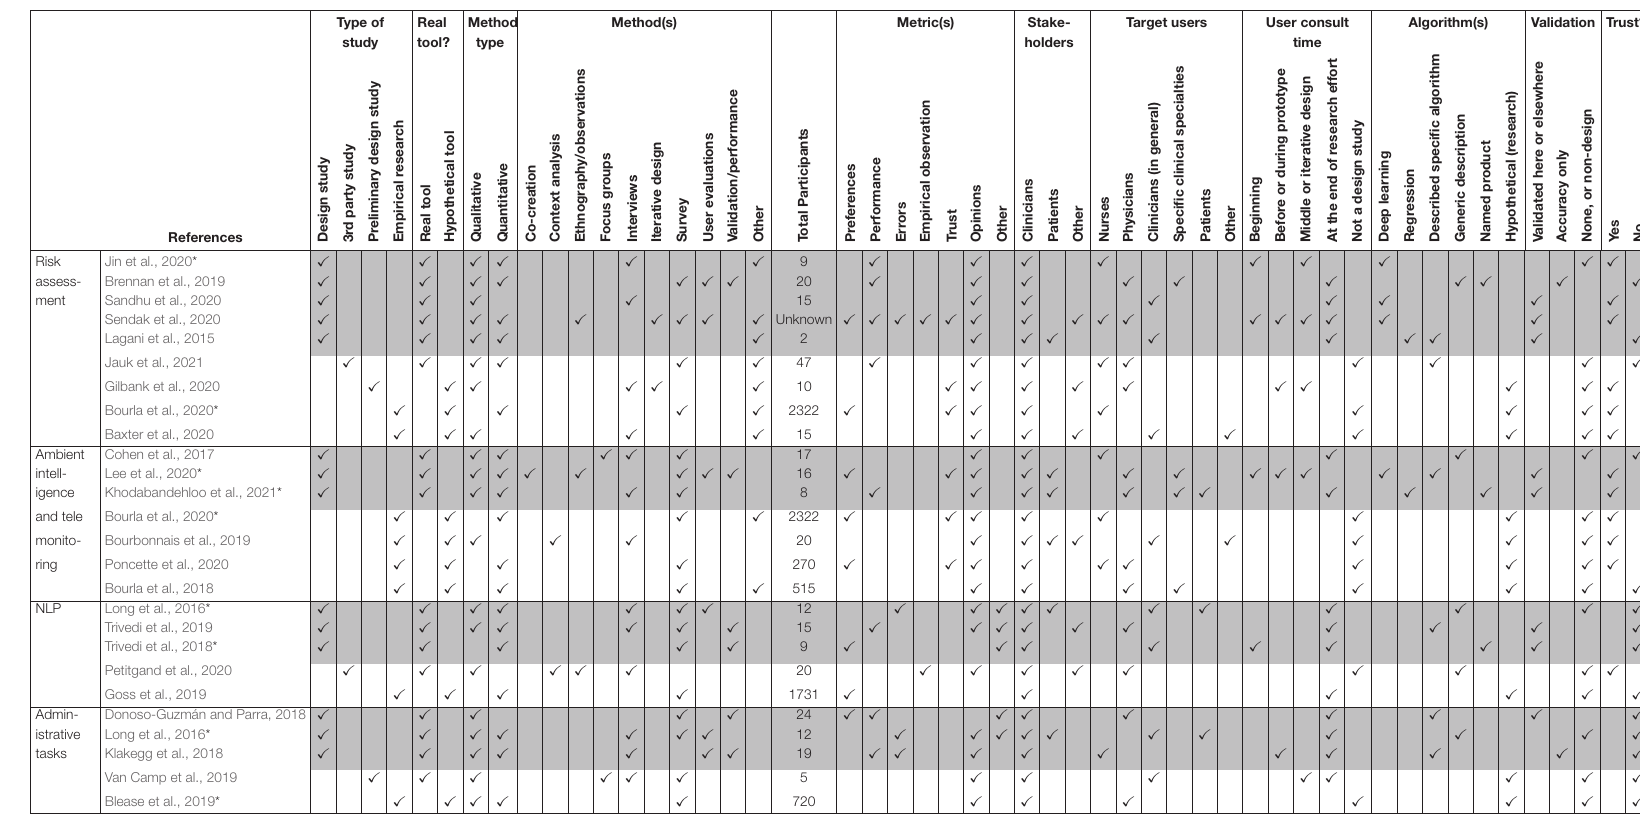
The gray rows designate “design” studies. *Indicates that paper appears in more than one